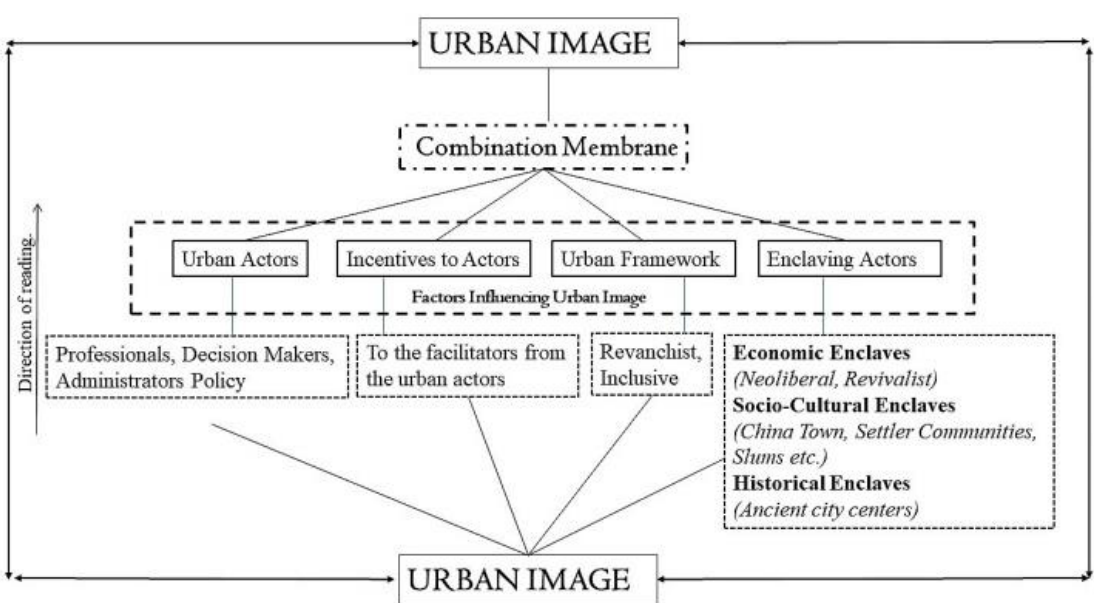
Figure 1. Mapping the theoretical terrain of factors shaping the urban image. The diagram is to be read from bottom up. Any combination of the factors, socio-cultural, economic and historical can coalesce into combination membrane and produce a distinct urban image.Source: Authors,